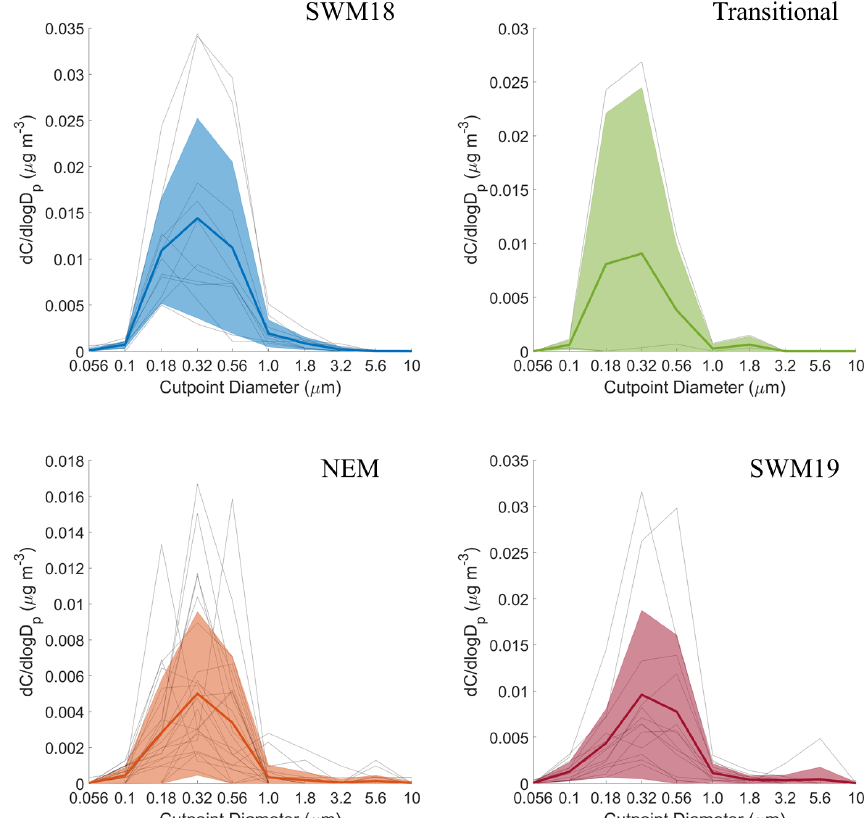
Figure 11. Same as Fig. 6 but for